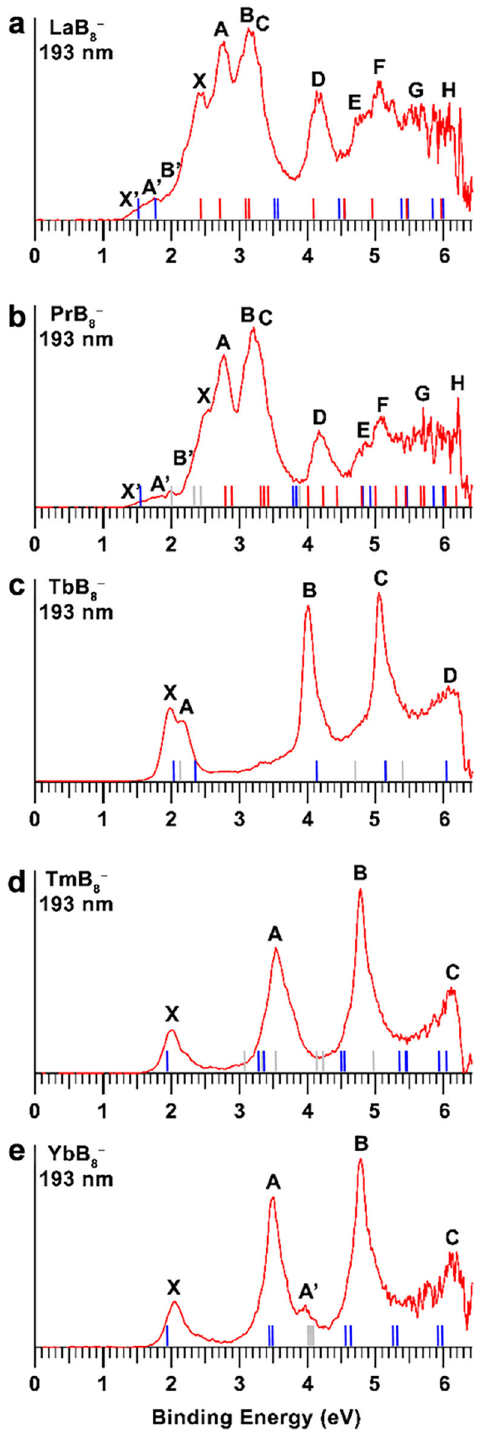
Fig. 1 Photoelectron spectra at 193 nm (6.424 eV) of LnB 8 − (Ln = La, Pr, Tb, Tm, Yb). a LaB 8 − . b PrB 8 − . c TbB 8 − . d TmB 8 − . e YbB 8 − . The blue and red bars in a and b represent computed VDEs of isomer I ( C 7v ) and isomer II ( C s ), respectively. The gray bars indicate the calculated 4 f -detachment C at 5.06 eV. Beyond 5.5 eV, the spectrum becomes nearly continuous and a band D at around 6.1 eV is tentatively assigned. The binding energies of all the observed bands are given in Supplementary Table 3.